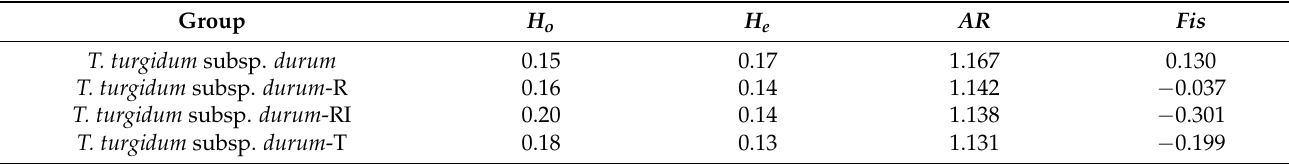
Table 1. Genetic parameters evaluated for the T. turgidum subsp. durum subset split into four groups: T. turgidum subsp. durum (all the other accessions), T. turgidum subsp. durum -R